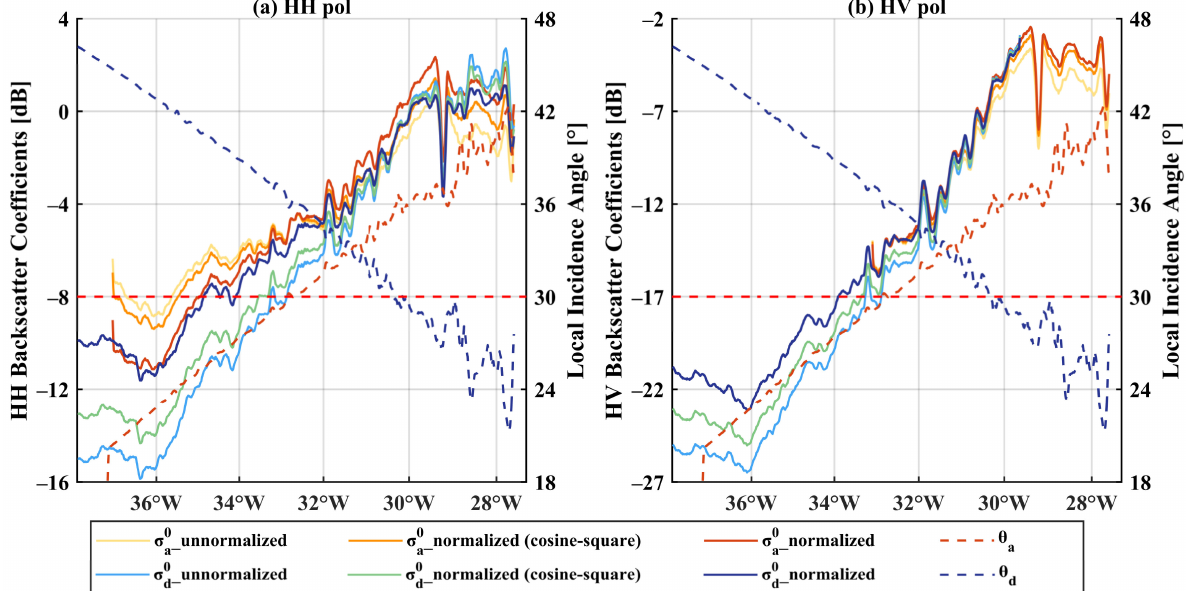
Figure 4. The profile obtained along the red line in Figure 3a of the backscatter coefficient before and after incidence angle normalization by the cosine-square method and the incidence angle correction method. The left vertical axis shows the backscatter coefficient variation and the right one shows the corresponding incidence angle change. The subscripts a and d refer to the ascending and descending images. The horizontal red dashed line indicates the reference incidence angle of 30 ◦